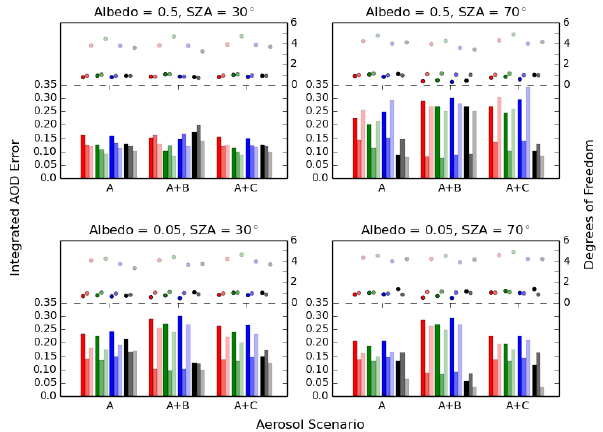
Figure 6. AOD error and DoF for the aerosol profile retrieval for surface albedos of 0.05 and 0.5 and SZAs of 30 and 70 ◦ for the four instruments. Errors are integrated over the 0–2 and 2–5km ranges as well as the total column for aerosol scenario A and combined aerosol scenarios A + B and A + C. Intensity offset is included.